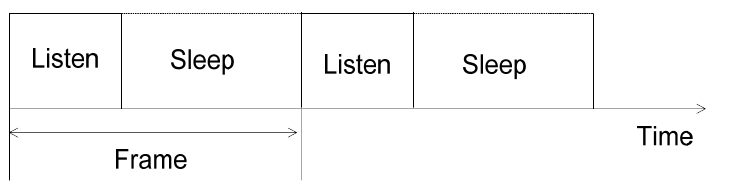
Figure 1. Scenario of periodic listen and sleep of a sensor